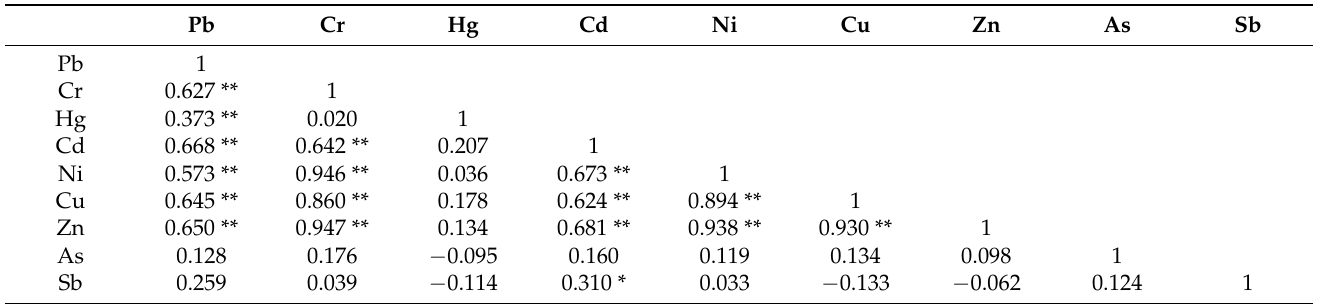
Table 3. The Spearman correlation coefficients (r) for the relationships between heavy metals in Lake Yangcheng ( n = 56). ** and * indicate significant correlation at the 0.01 level (2-tailed) and at the 0.05 level (2-tailed),